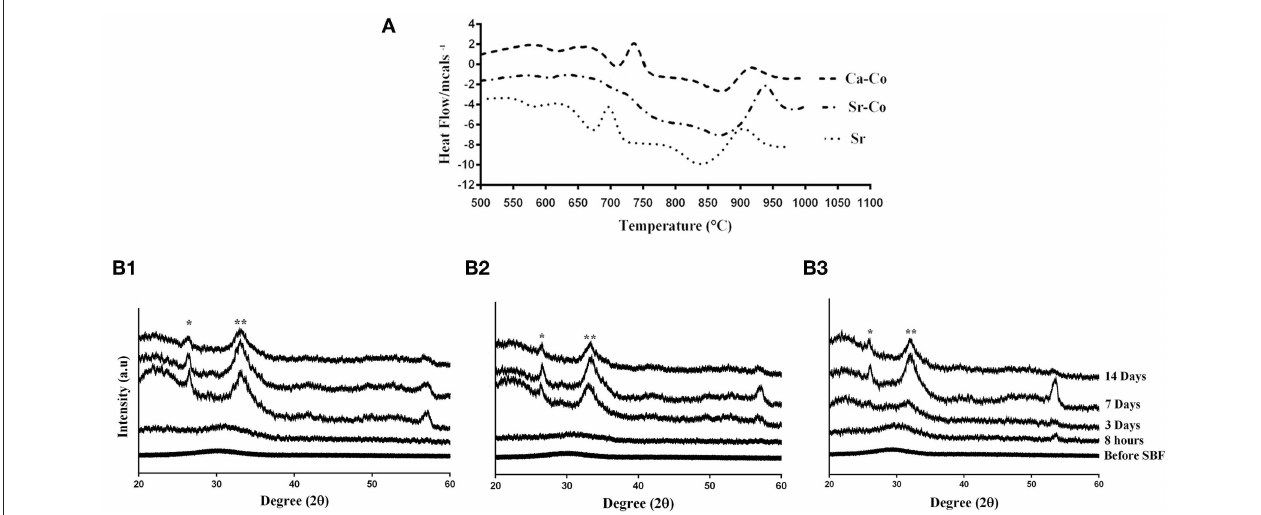
FIGURE 2 | Data related to physico-characterization of the as-prepared BGs. (A) Glass transition temperature (Tg) of the glass samples determined by differential scanning calorimetry (DSC) analysis. (B1–B3) XRD spectra of the samples (Sr-, Ca-Co, and Sr-Co glasses, respectively) before and after incubation in SBF. With some modifications from Reference ( Kargozar et al., 2016). * and ** are related to the peaks of the formation of silica gel and hydroxyapatite like layer at 2 θ = 26 ◦ and 2 θ = 32 ◦ , respectively.